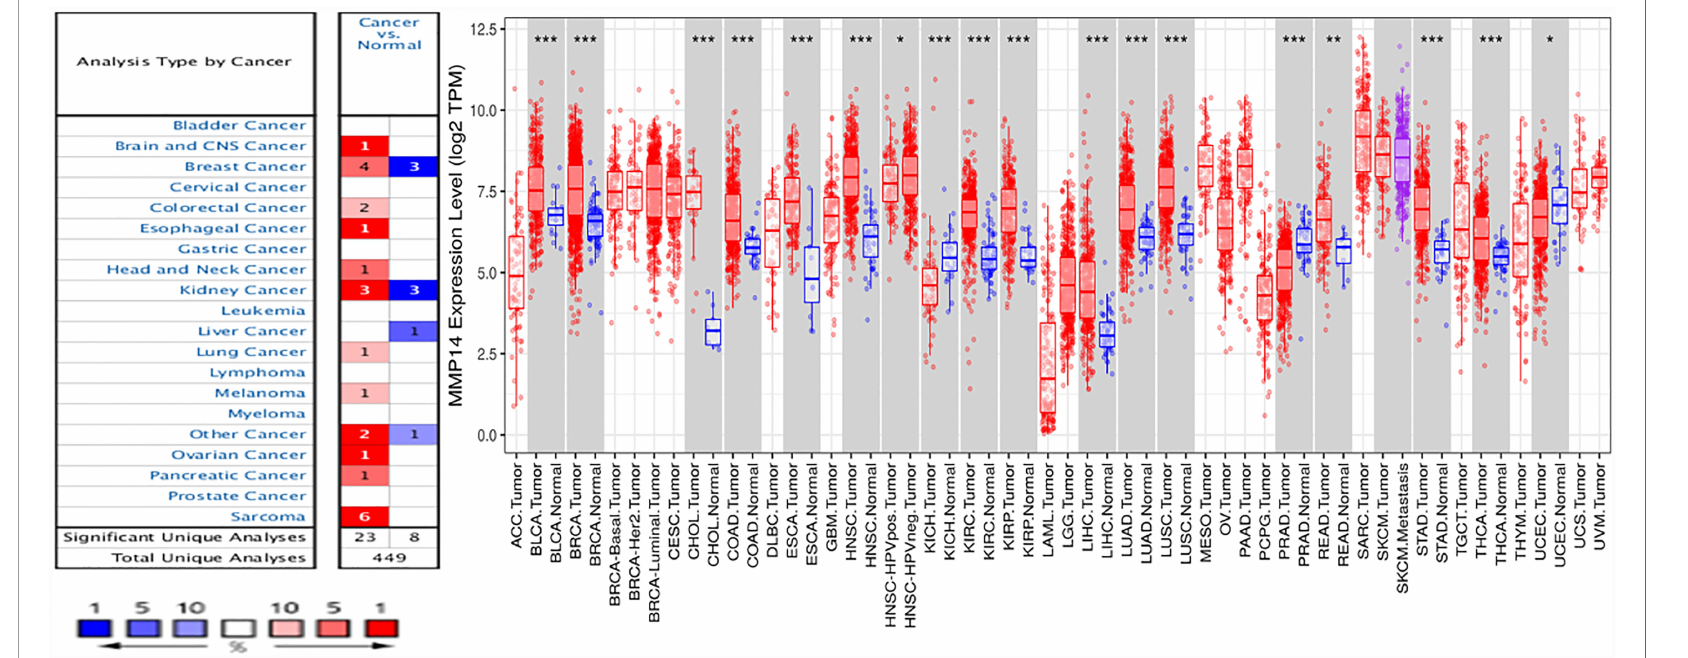
FIGURE 1 | Differences in MMP14 expression in tumor tissues and normal tissues across cancers. (A) The Oncomine database was used to analyze the expression of MMP14 in tumor tissues and normal tissues. The number in each cell is the total amount in the dataset. (B) Analysis and comparison of MMP14 expression in different tumor tissues and normal tissues in TCGA database. *P < 0.05, **P < 0.01 ***P <